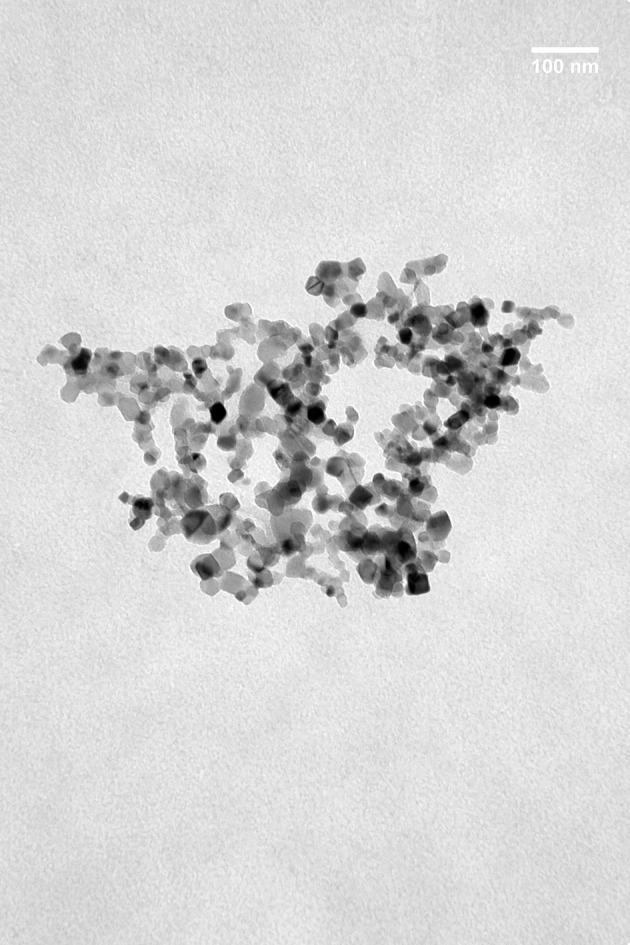
TEM image of the TiO2NPs.